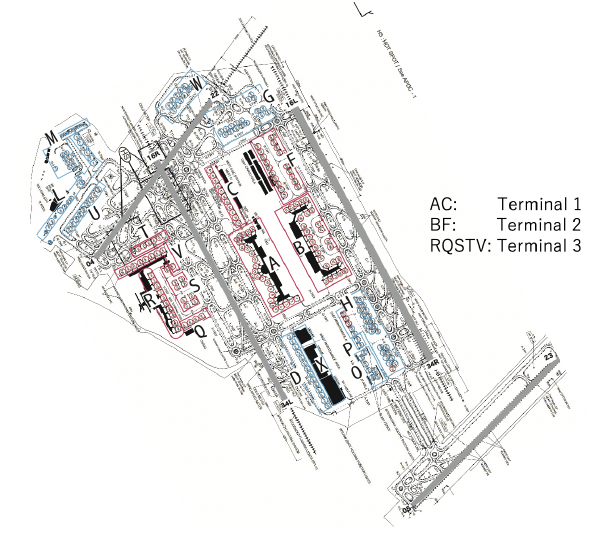
Figure 1. RJTT surface configuration